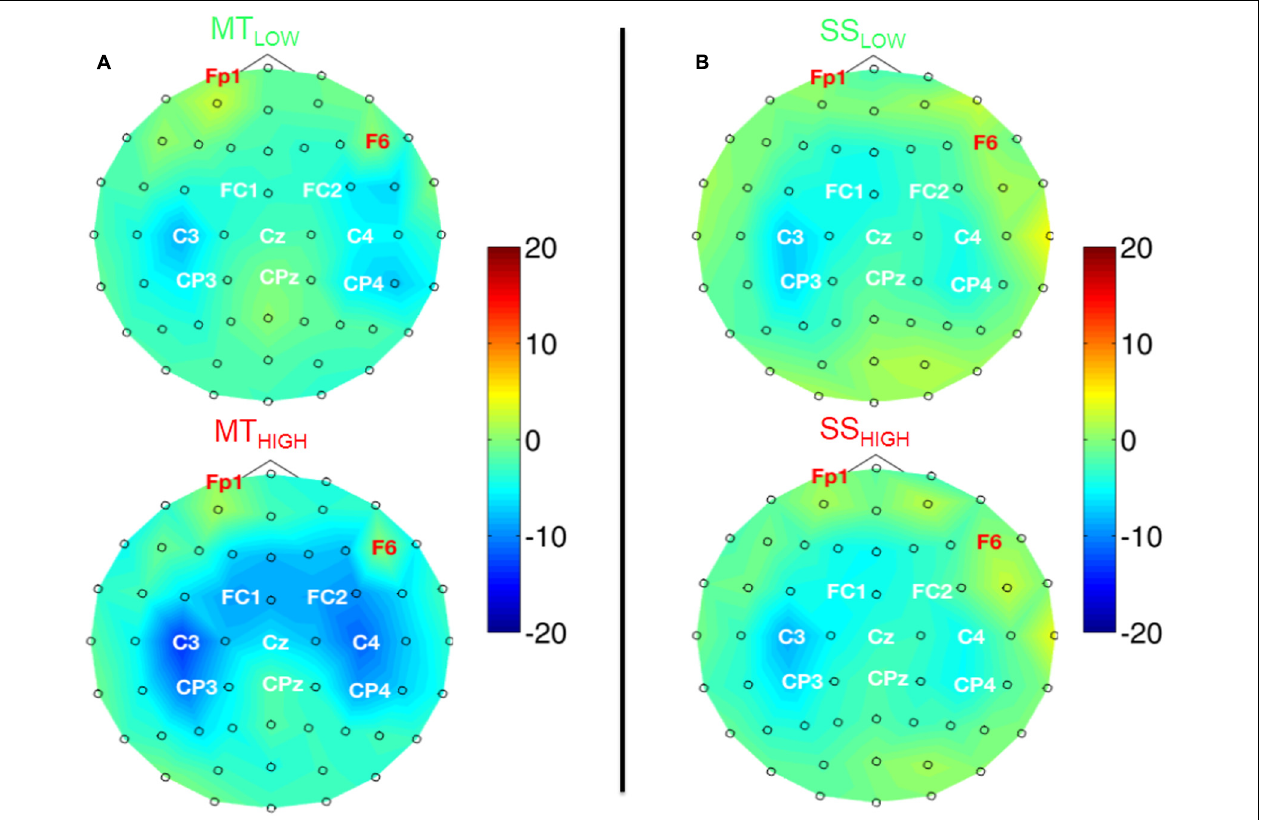
FIGURE 5 | Scalp maps depicting power changes in the beta band during execution of the MT (subfigure A ) and sensory stimulation of the fingertips (SS; subfigure B ) relative to rest and averaged over all subjects. Event-related synchronization (ERS) is encoded in red and desynchronization (ERD) in blue. Channels denoted with red letters were removed from the analysis and set to neutral in the plots. All experimental conditions were characterized by a peak ERD around the contralateral motor cortex (C3). Execution of the MT with high intensity showed some involvement of the contralateral centro-parietal cortex (CP3) and a spread toward fronto-central areas. SS with low and high intensity showed a lateralization toward the contralateral motor cortex (C3) and only little involvement of the ipsilateral sensorimotor areas. There were no significant differences within the ERDs caused by the MT with low and high intensity or SS with low and high